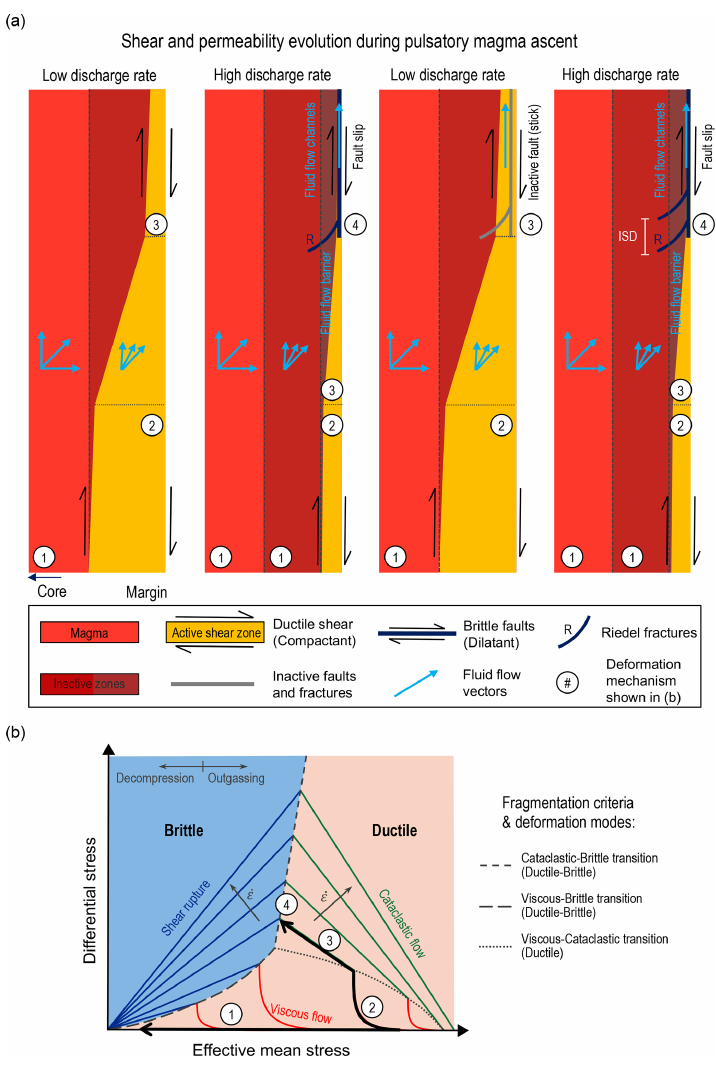
Figure 9. (a) Conceptual model showing rheological shifts and evolution of permeability (seen as fluid flow vectors) during pulsatory magma ascent and stick-slip faulting. The sketches illustrate the evolution of the extent of active shear zones (in orange), inactive areas (dark reds), active faults (blue), and inactive faults (grey) during magma discharge fluctuations through time. The dominant rheology in each area is numbered (1–4) and is linked to the deformation mechanism map for magma (shown in b ). The sketches (a) show that shear narrows toward the eruption point as magmas are subjected to lower effective pressure (as shown in b ). Compaction of the outer margin of the shear zones (dark red–brown) would generate a zone of lower permeability (which may act as a local fluid flow barrier). As discharge rates increase, the width of the shear zone also narrows and promotes a switch to brittle failure at shallow depth ( ∼ 500m), causing the propagation of a primary fault plane and an adjacent Riedel fracture (which channels fluid flow; blue arrow). Upon discharge rate reduction, the shear zone would widen again and the fault would become inactive (stick phase), shifting the Riedel fracture to shallower depth. Upon renewed discharge rate increase, shear would narrow again, and faulting would generate another Riedel fracture. Thus, the distance between Riedel fractures may be used to resolve the magma ascent associated with inter-seismic deformation (ISD). (b) Sketch of a deformation mechanism map for magma (adapted from Lavallée and Kendrick, 2020). At low differential stresses magma flows viscously, but at higher differential stresses, magma may undergo the glass transition and the deformation mode may switch to brittle rupture (dilatant shear) or ductile cataclastic flow (compactant shear), depending on the effective mean stress. These deformation modes form yield caps, displayed by the blue and green lines representing brittle rupture and ductile cataclastic flow, respectively. Each line refers to a given strain rate condition, and the sketch shows an increase in strength as a function of strain rate ( ˙ ε ); in the brittle field, the strain rate may increase with differential stress and/or by lowering the effective mean stress, whilst in the ductile field, the strain rate may increase with differential stress as well as effective mean stress. The inset double-headed arrow indicates magmatic scenarios which may influence the effective mean stress: for instance, decompression or pore pressurisation may reduce the effective mean stress, whilst outgassing may increase it. The numbers refer to scenarios as displayed for different parts of the magmatic column in (a)